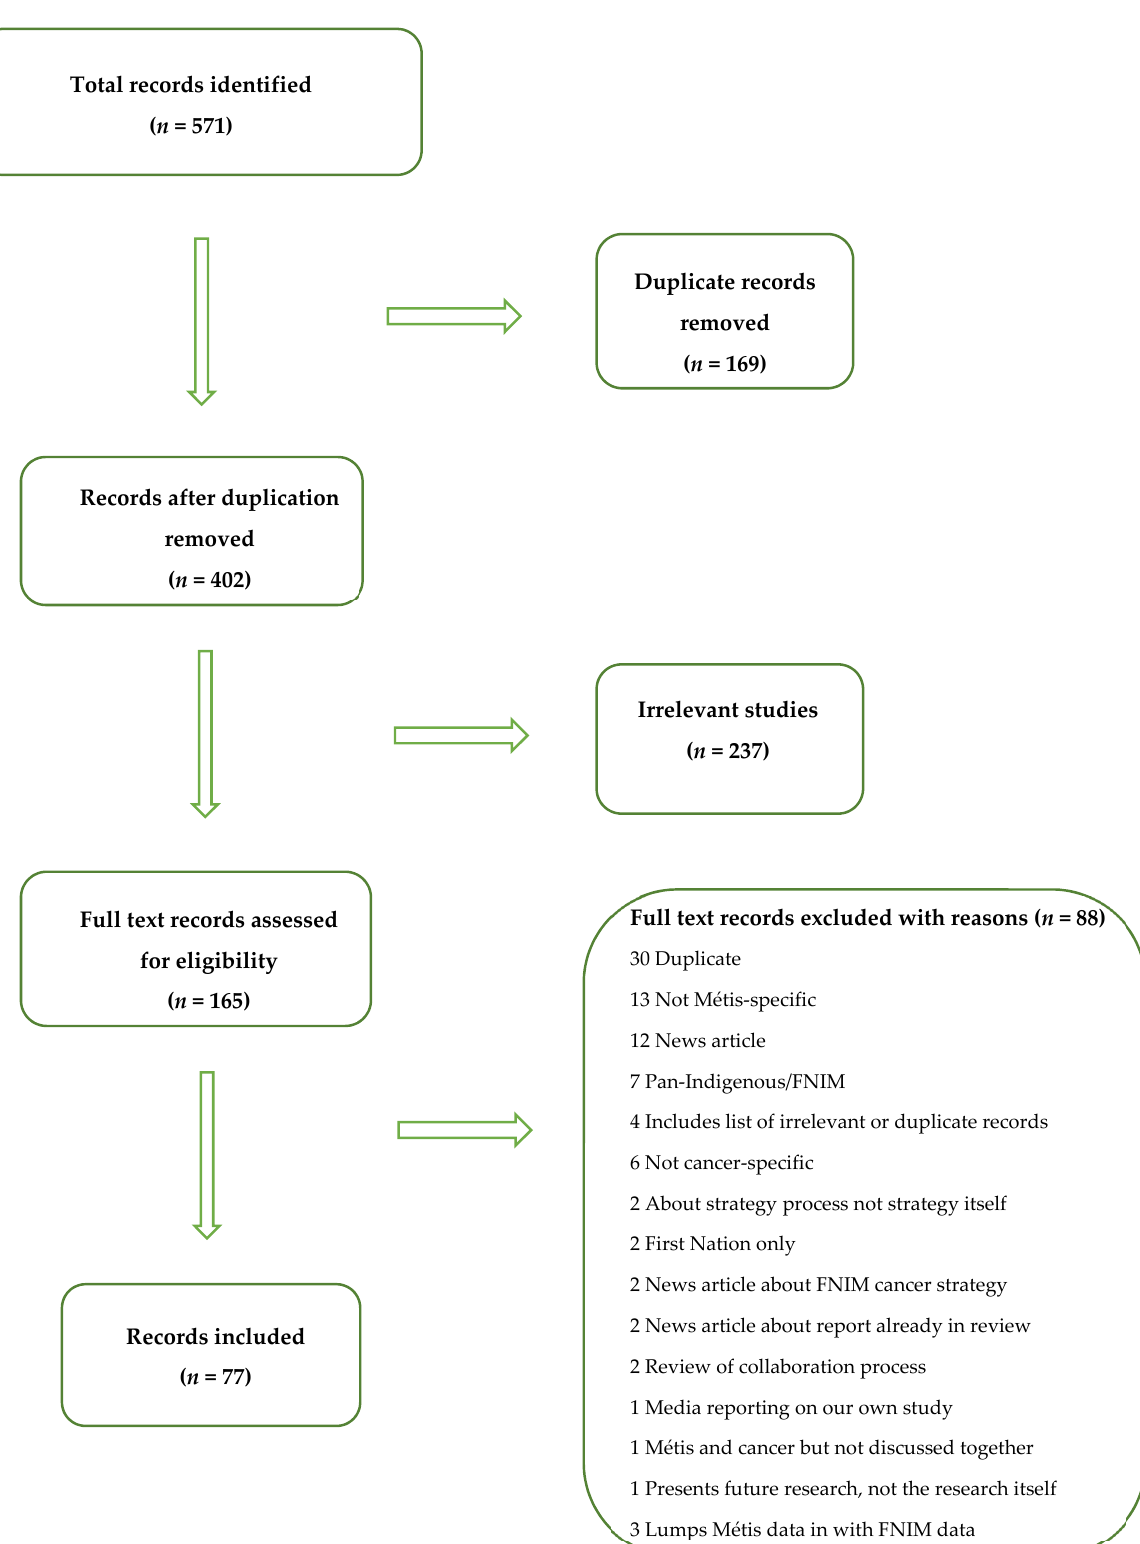
Figure 1. Summary of the screening and selection process.